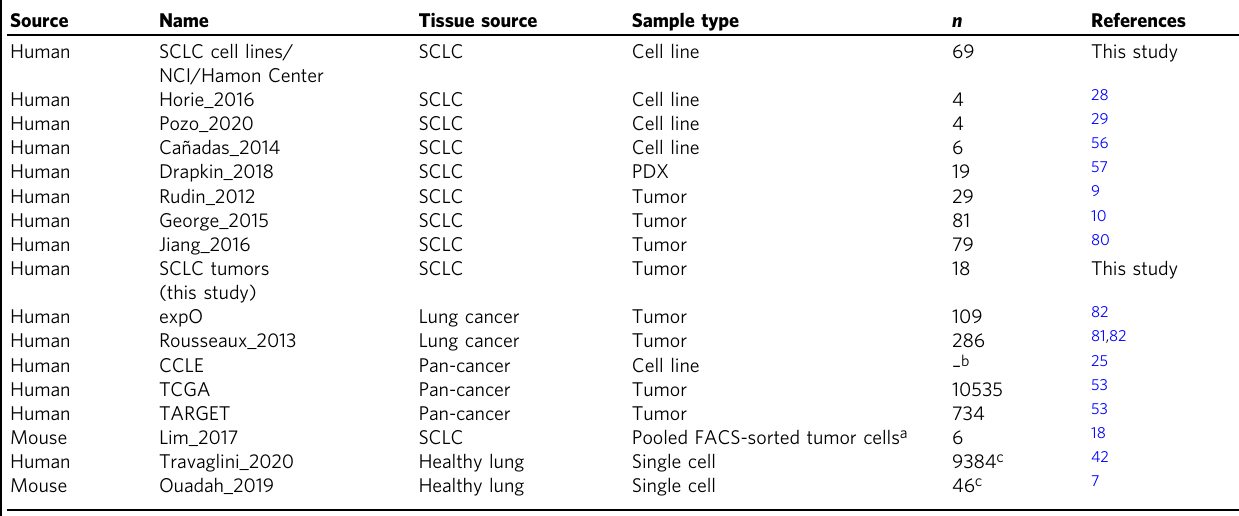
Table 1 Data sets used for